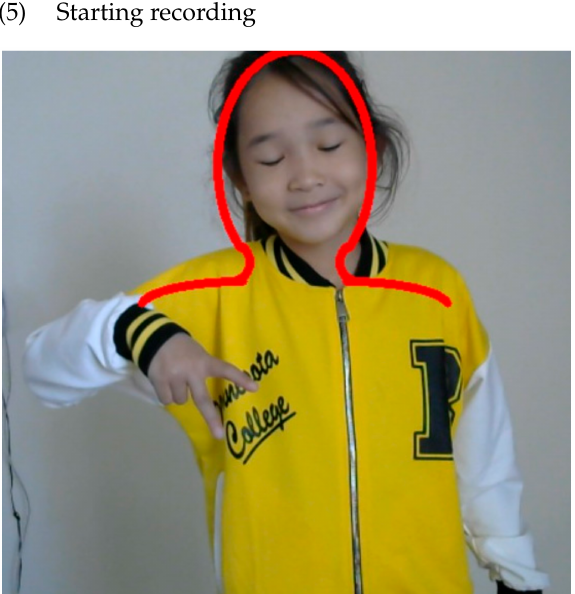
Figure 8. Draw_people